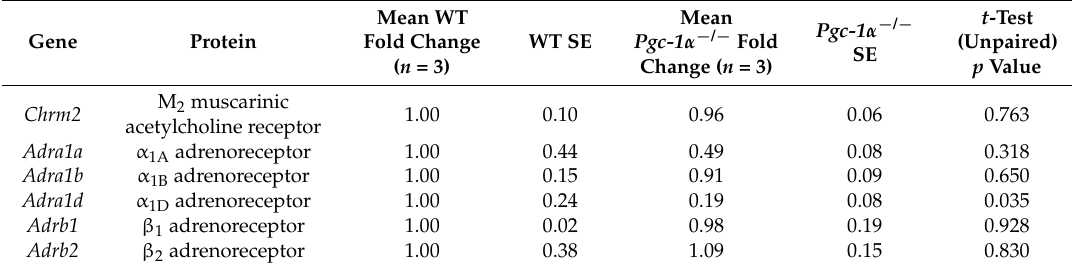
Table 6. The mean gene fold changes underlying adrenergic and cholinergic receptors in Pgc-1 α − / − compared to WT